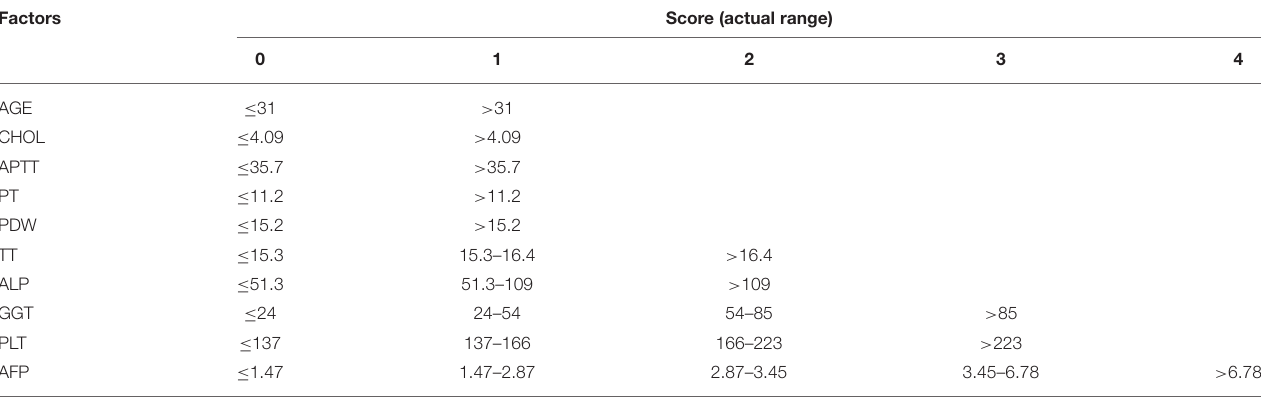
TABLE 2 | The levels and optimal candidate values of final indicators. Factors